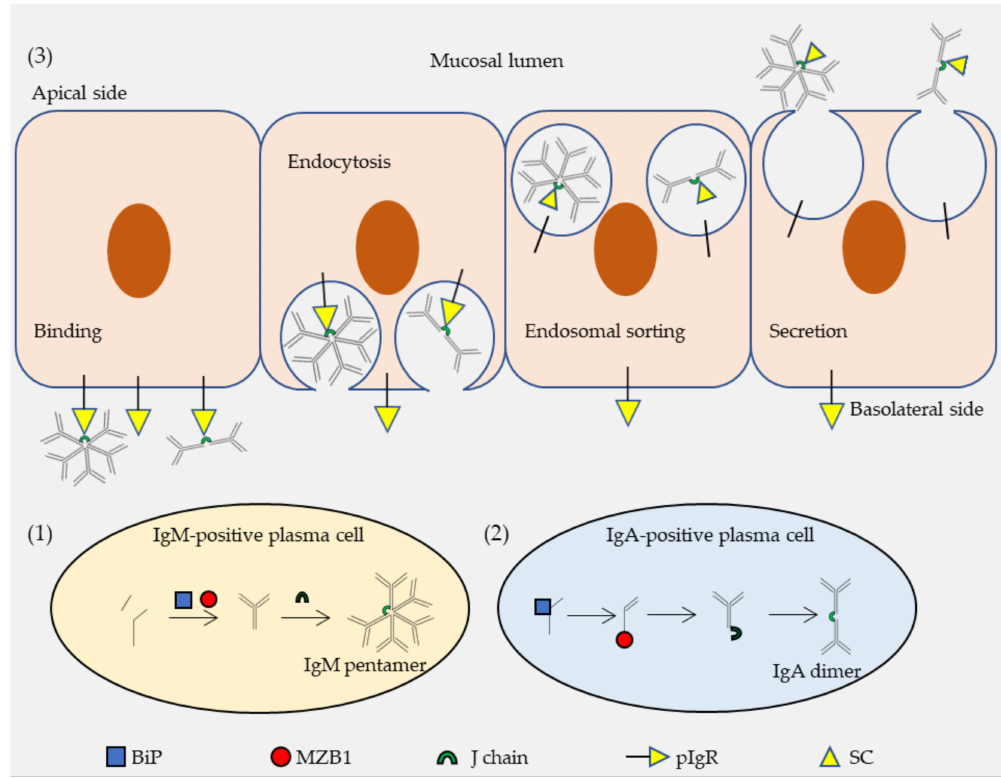
Figure 2. A proposed scheme for transcytosis of polymerized IgA (immunoglobulin A) and IgM (immunoglobulin M). ( 1 ) Formation of the IgM pentamer is mediated by marginal zone B and B-1 cell specific protein (MZB1) and J chain. MZB1 assists the assembly of IgM as a co-chaperone of the glucose-regulated protein 94 (GRP94)-binding immunoglobulin protein (BiP) complex. J chain aids formation of the IgM pentamer. J chain-containing IgM pentamers are secreted from IgM-positive plasma cells. ( 2 ) Formation of the IgA dimer is mediated sequentially by BiP, MZB1 and J chain. BiP binds and stabilizes the α heavy chain. MZB1 binds to the α heavy chain and stabilizes the light chain-heavy chain complex. J chain joins two IgA monomers. J chain-containing IgA dimers are secreted from IgA-positive plasma cells. ( 3 ) Polymeric immunoglobulin receptor (PIgR) mediates transcytosis of IgA dimers and IgM pentamers. IgA dimers and IgM pentamers, via the J chain, bind to the pIgR on the basolateral membrane of the epithelial cells. The Ig-pIgR complex undergoes clathrin-mediated endocytosis and is conveyed through the endosomal sorting pathway. PIgR is cleaved and its extracellular portion, the secretory component (SC), remains bound to the immunoglobulin (Ig) polymers. The SC-Ig polymer complex is released from the apical membrane of epithelial cells and secreted into the mucus. Note that the molecules and cells in this figure are not to